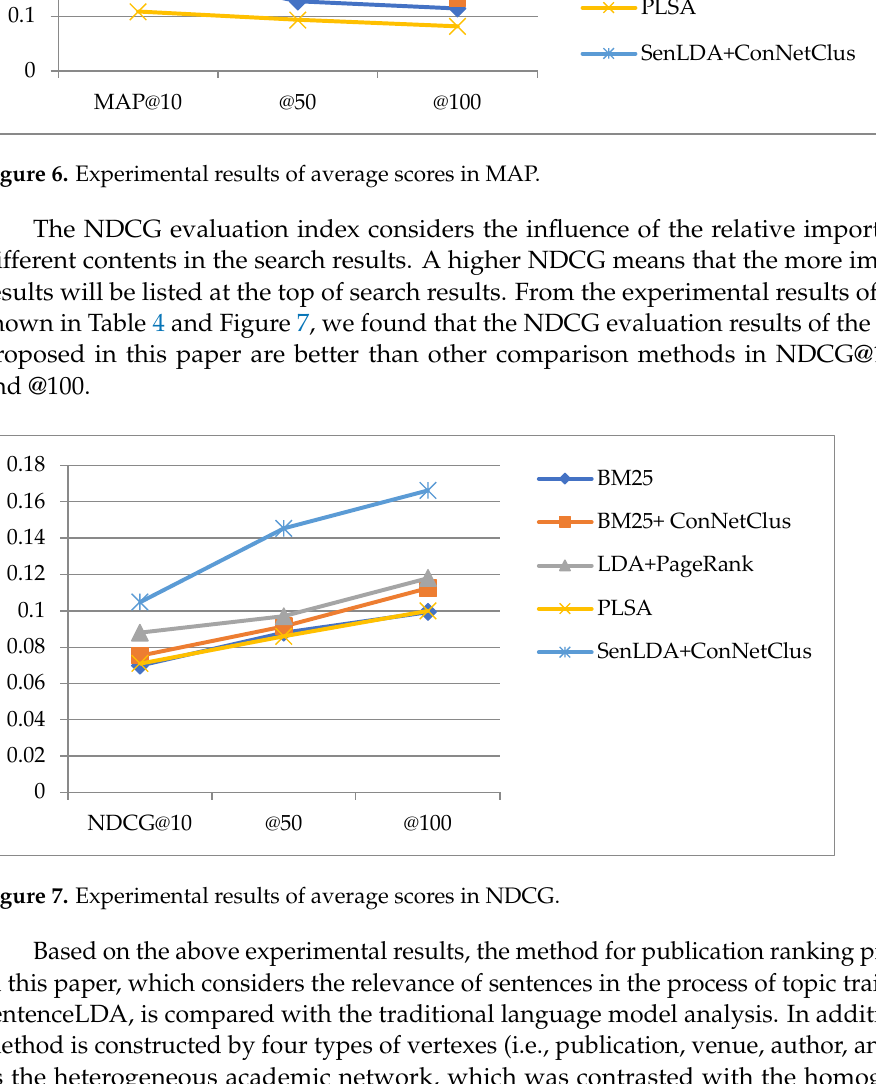
Figure 6. Experimental results of average scores in MAP.